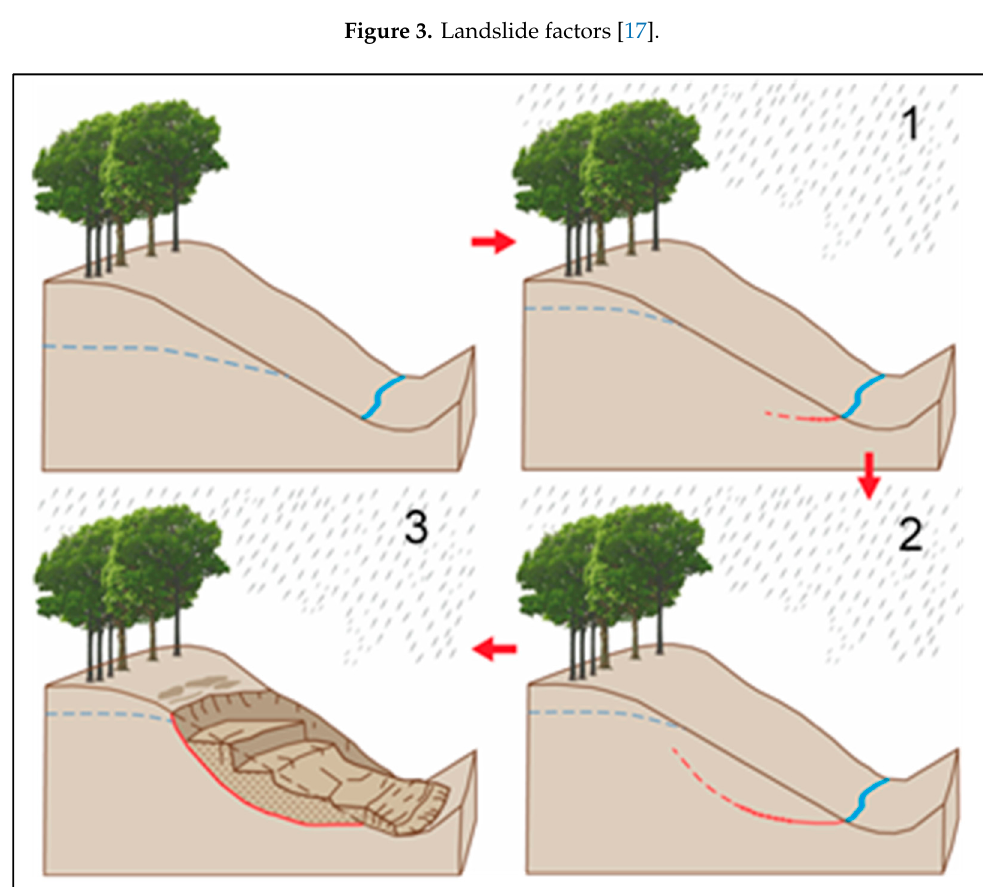
Figure 4. Landslide mechanism: from the triggering action ( 1 ), through the development of the shear band ( 2 ) until the final mobilization of the landslide body ( 3 ).